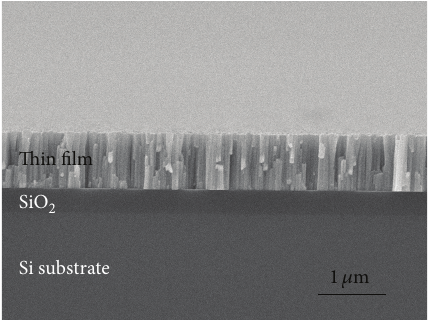
Figure 2: The cross section micrograph of the as-deposited FCN film which shows the typical columnar